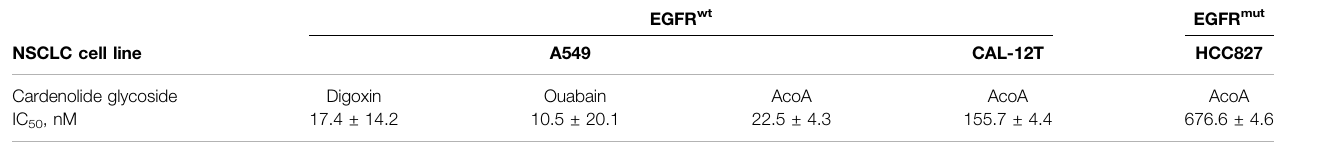
TABLE 2 | IC 50 values (nM) of cardenolide glycosides in NSCLC cell lines (48 h